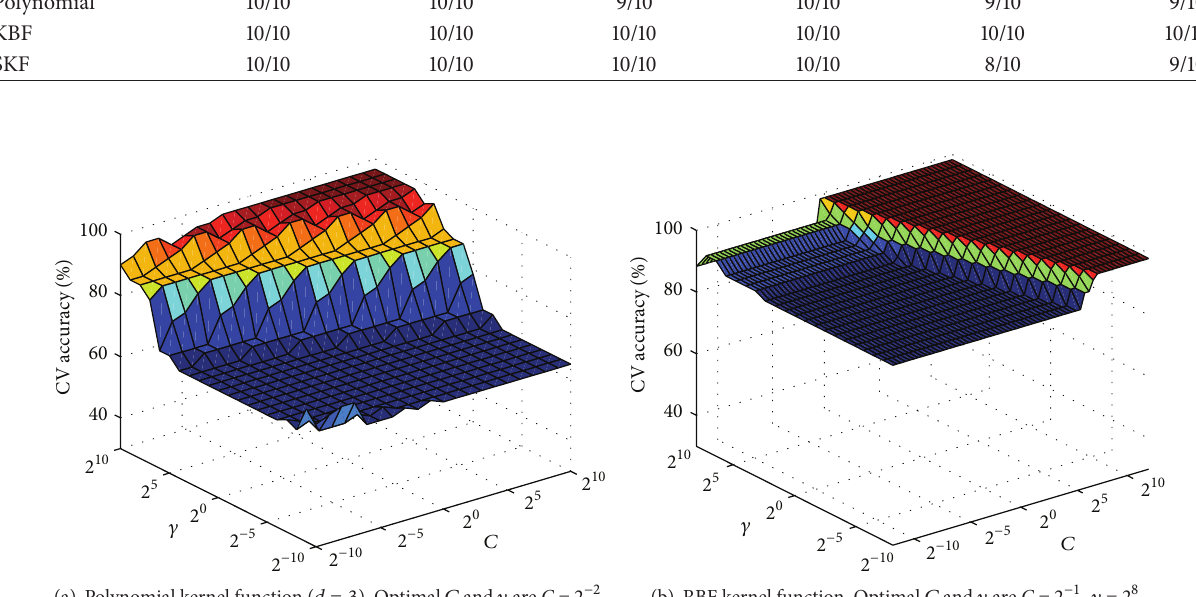
(b) RBF kernel function. Optimal 𝐶 and 𝛾 are C = 2 −1 , 𝛾 = 2 8